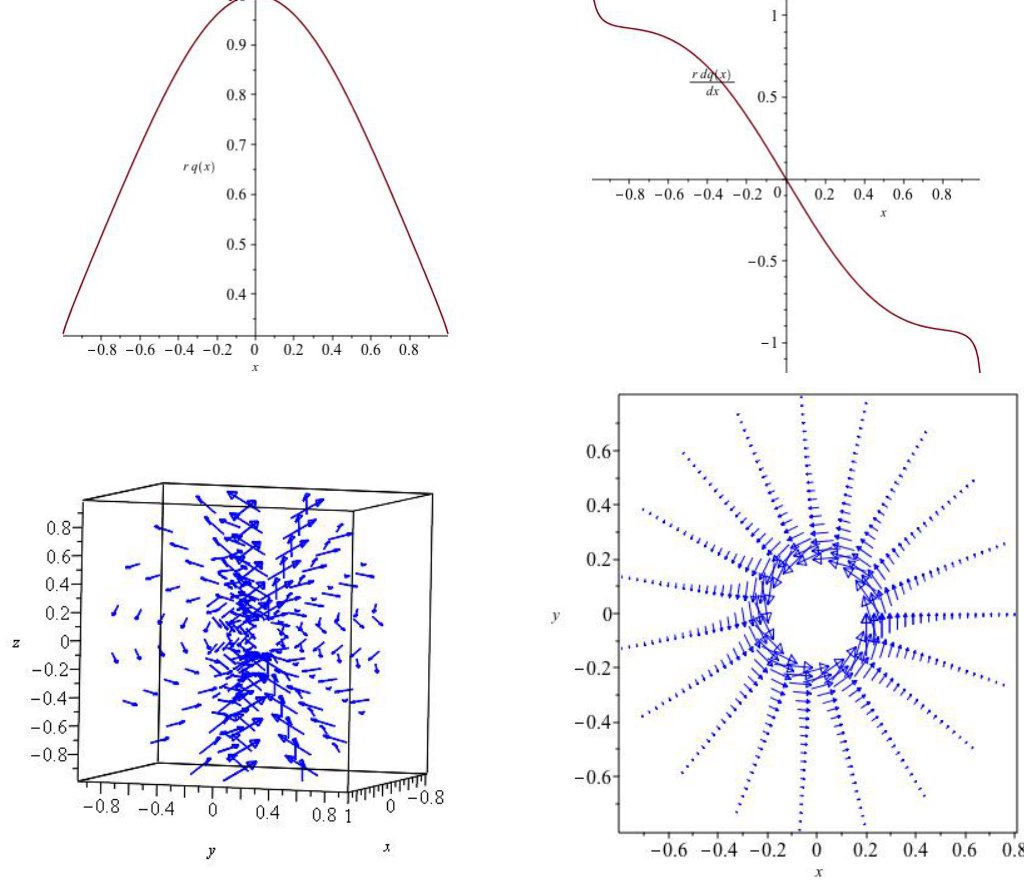
Figure 2. At upper left we show ¯ q = r ∗ q as a function of cos θ . We have chosen the symmetric example with q ( 0 ) = 1 and the derivative equal to zero. The derivative is shown at upper right. The field vectors, multiplied by r 2 , are shown above and below the equatorial plane at lower left. The radius runs from 0.2 to 0.8 in arbitrary Units although this dependence has been removed from the magnetic field. At lower right the true field vectors are shown in the equatorial plane over the same range in radius. The radial component passes through zero in this